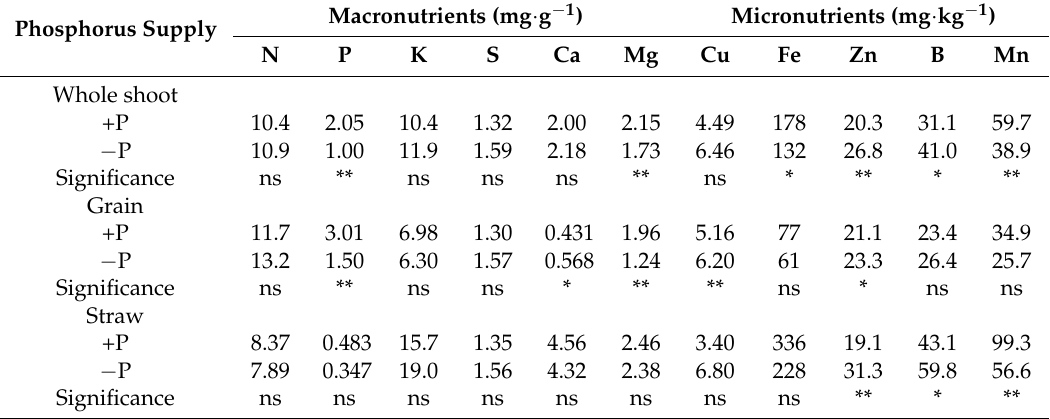
Table 2. Concentration of key nutrients in rice above-ground tissue, grain, and straw under P-deficient and P-replete growing conditions in the field. Significant differences are denoted by * ( p < 0.1), ** ( p < 0.05), or ns (not significantly different at p =